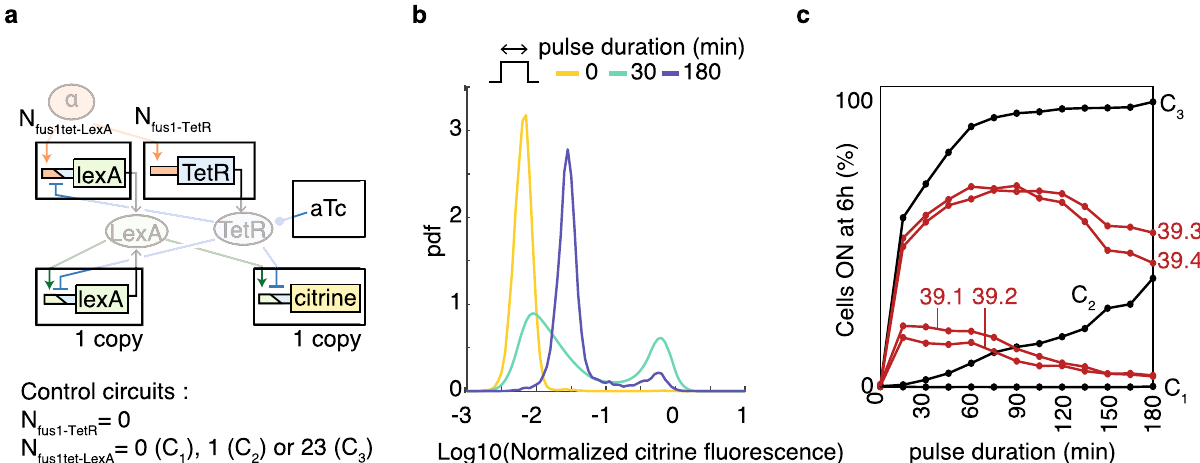
Fig. 5 Implementation of the predicted decoder. a Variants of T 39 differ in the copy number N of α -factor inducible TetR and LexA constructs. Control circuit variants (C 1 – 3 ) lack α -factor inducible TetR. b Distributions of single-cell responses of T 39.2 to 1 μ M α -factor pulses (durations indicated by colors) at 100 nM aTc as determined experimentally by fl ow cytometry. All fl ow cytometry measurements include at least 4000 cells after gating. Fluorescence is normalized to the FSC-A signal, see “ Methods ” section. c Responses of the indicated T 39 variants and control circuits at 6 h to different 1 μ M α -factor pulse durations at 100 nM aTc in percentages of cells above a fl uorescence threshold (unimodal response of C 3 to a 3 h pulse is 95%), to accommodate for bimodal